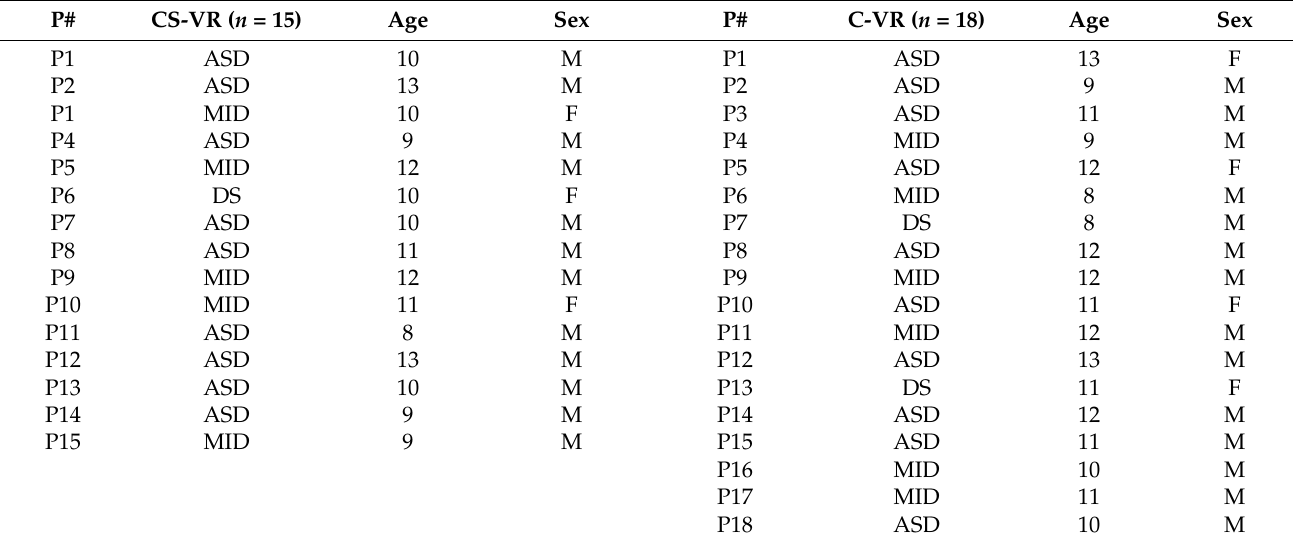
Table 9. Clinical and demographic characteristics of the